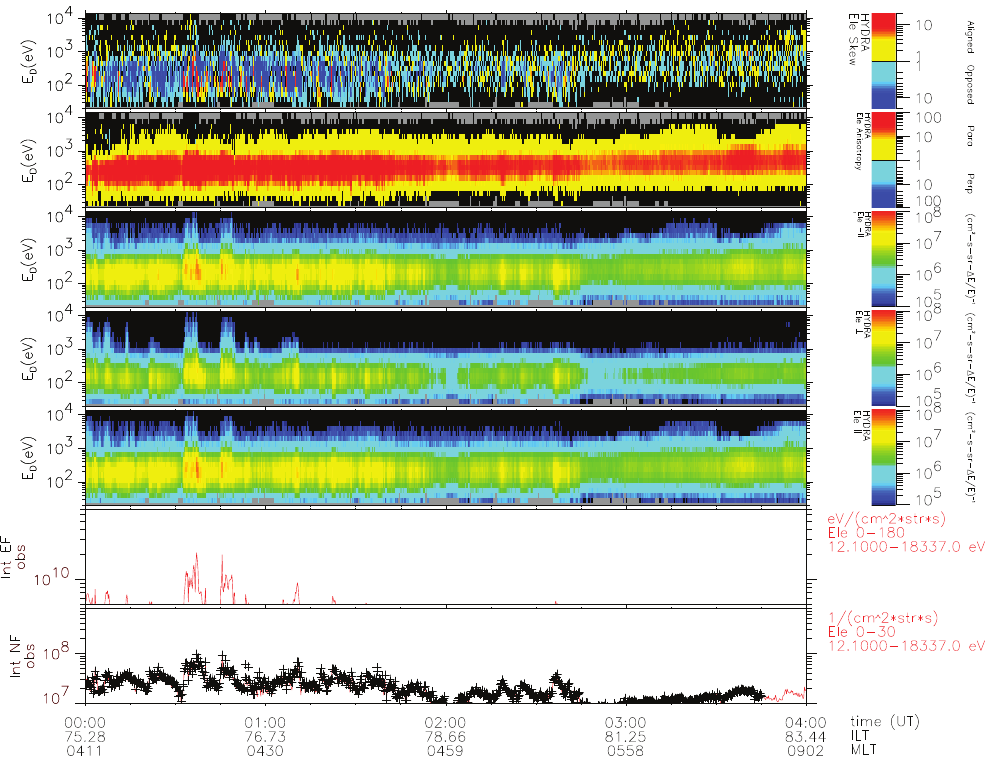
Fig. 7. Polar observations of DEFs (J) for the interval 00:00–04:00UT. Panels from top to bottom show: (i) electron skew: J || /J −|| , (ii) electron anisotropy: 1/2[ J || + J −|| ]/ J perp , (iii) antiparallel flux, (iv) transverse flux, (v) parallel flux, (vi) integral energy flux, and (vii) integral number fluxes parallel and antiparallel to the field.